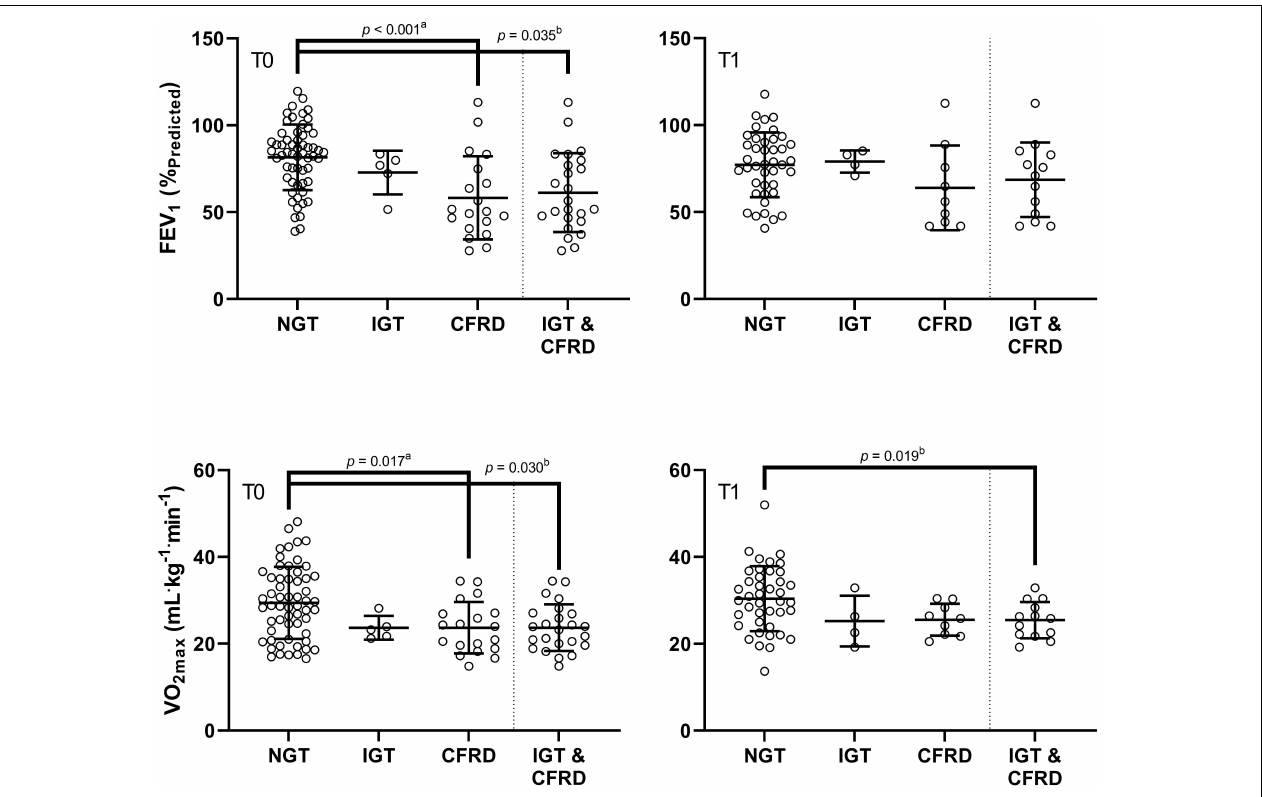
FIGURE 2 | Comparison of FEV 1 (% Pred ) and VO 2max in groups of differing glycaemic status at baseline (T0) and at one-year follow up (T1). CFRD: cystic fibrosis related diabetes; IGT: impaired glucose tolerance; NGT: normal glucose tolerance. FEV 1 : forced expiratory volume in 1 s as a percentage of predicted; VO 2max : maximal oxygen uptake. P -values are derived from post hoc tests following one-way ANOVA (a), and repeated measures ANOVA (b).